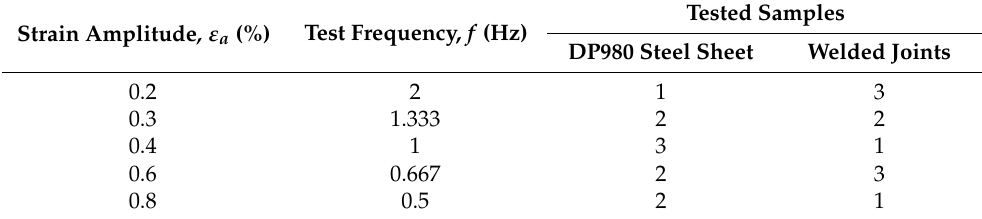
Table 2. LCF experimental test